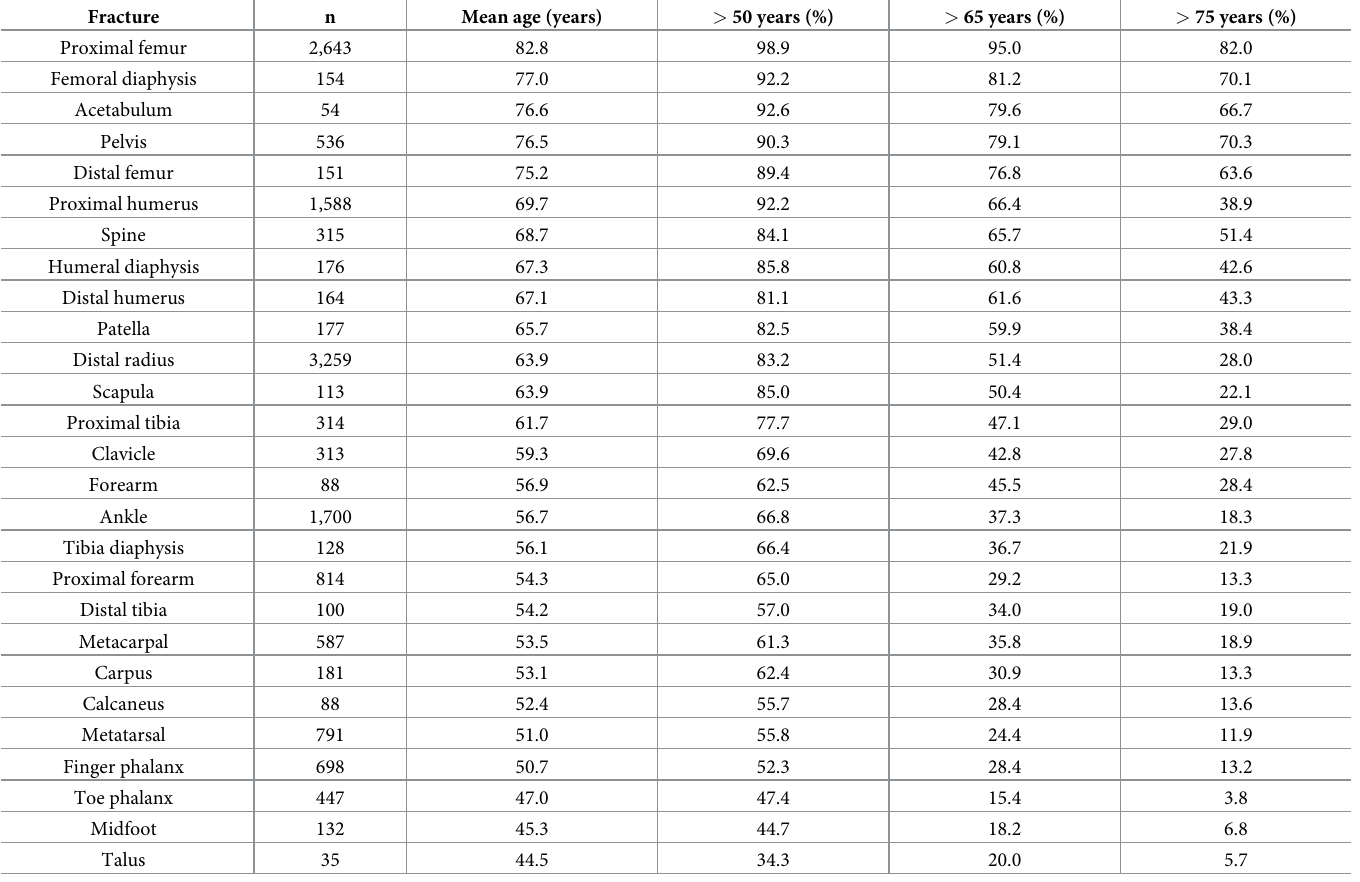
Table 5. Numbers of all fractures occurring in women, arranged in order of decreasing mean age, and with proportion of each of the fracture types in patients over 50, 65, and 75 years of age.